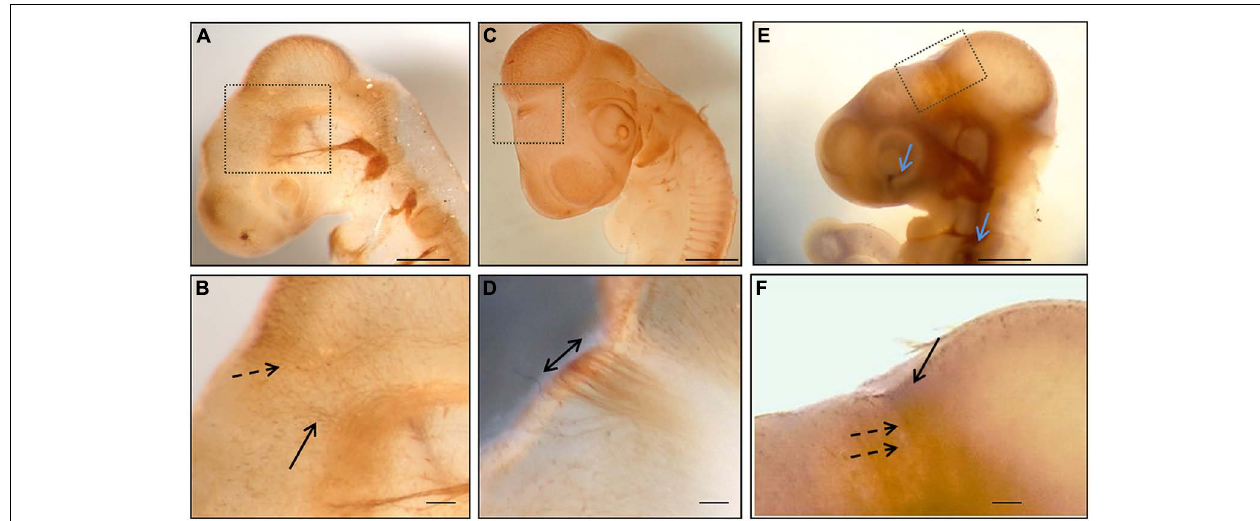
FIGURE 1 | Whole mount immunohistochemistry during the first stages of posterior commissure development. (A,B) HH17 embryos immunolabeled with 3A10 clone (DSHB) showing axons from neurons of the dorsal area of prosomere 1 (discontinuous arrow in B ) and from the basal diencephalon (continuous arrow in B ). (C,D) HH18 chick embryo immunostained with anti-tubulin β III showing the posterior commissure as the first transversal tract on the dorsal encephalon (double arrow in D